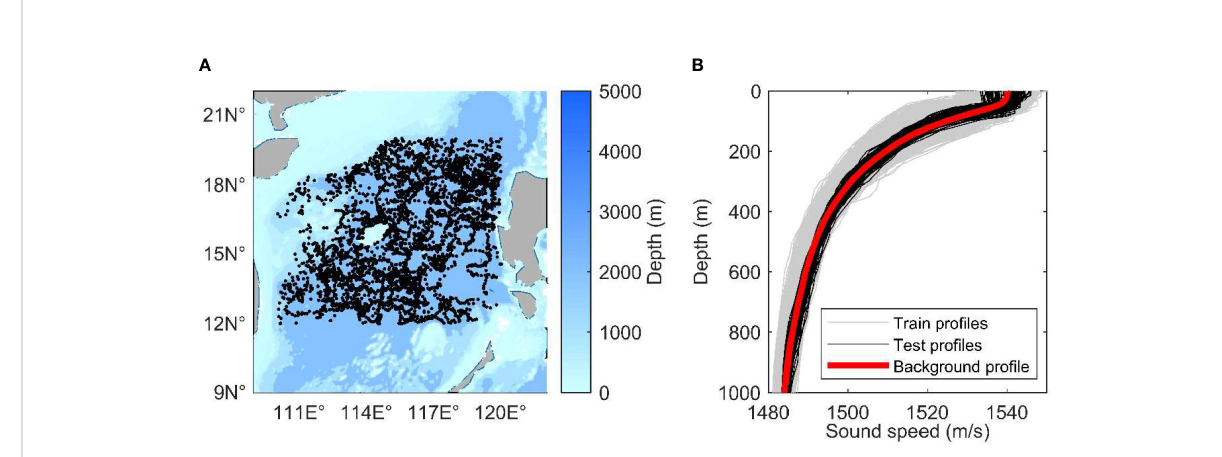
FIGURE 2 (A) Distribution of the Argo samples in the South China Sea. (B) Training, test, and background pro fi